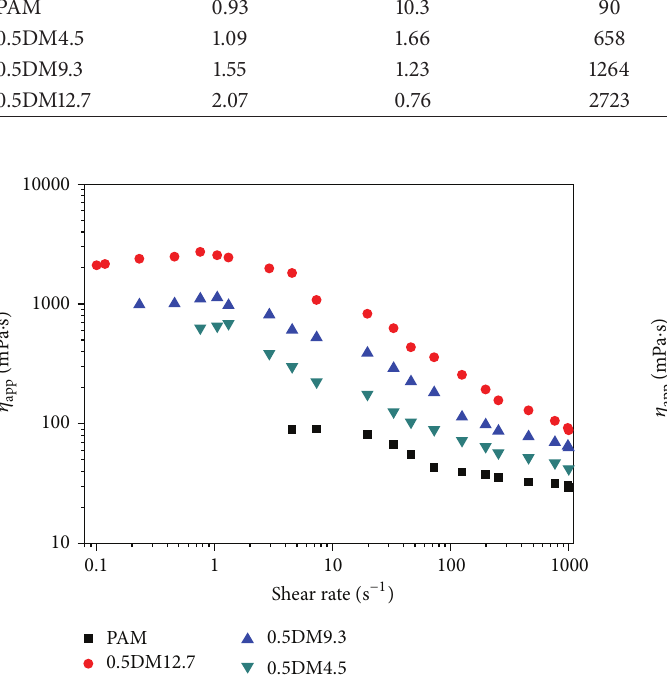
Figure 7: Variation of apparent viscosity as a function of shear rate for PAM, 0.5DM12.7, and 0.5DM4.5 ( 𝑐 𝑝 = 1.0g dL −1 , 𝑇 = 25 ∘ C).